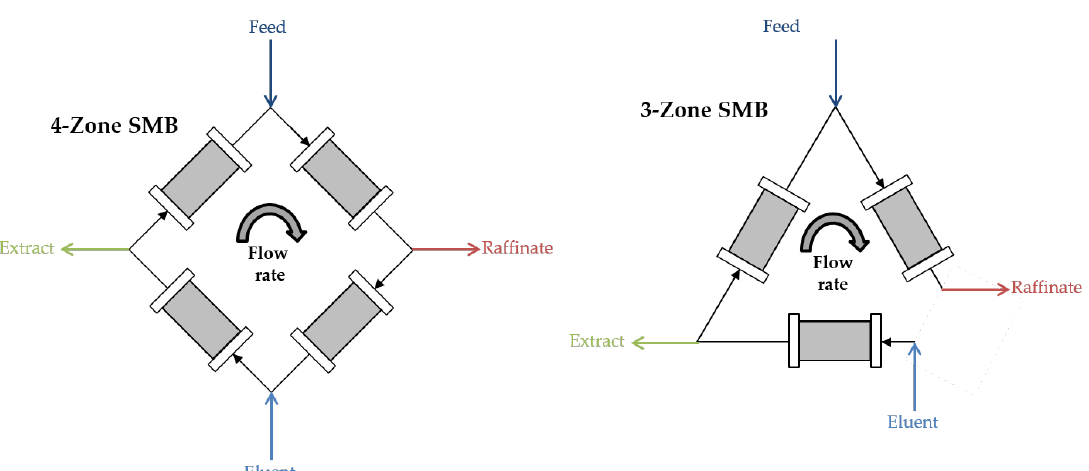
Figure 4. Schematic process setup for the 4-zone simulated moving bed (SMB) and the reduced 3-zone SMB (acc. to [30–32]).